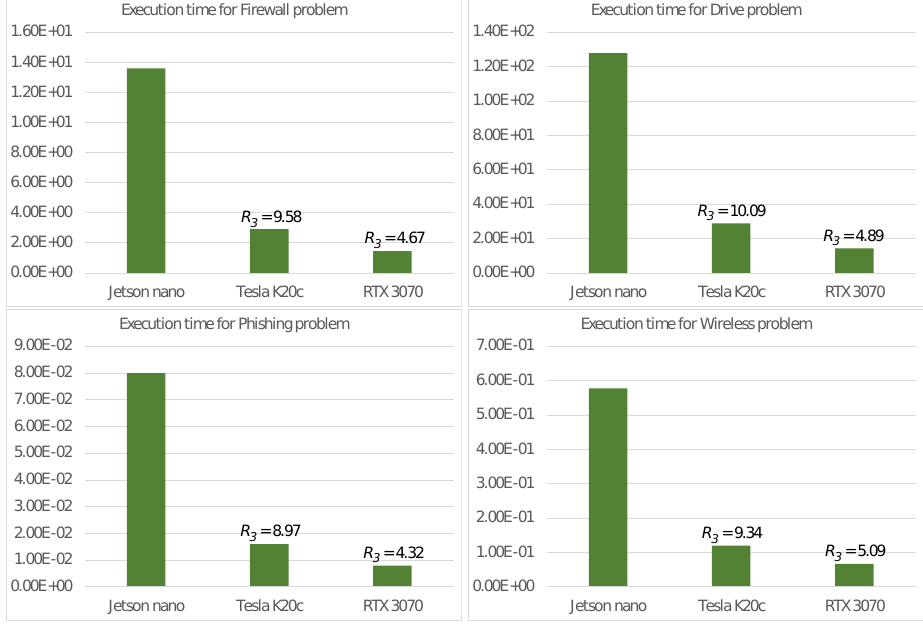
Figure 4. Execution times (in seconds) and energy consumption ratio R 3 of the two high end GPU boards compared with the Nvidia Jetson Nano